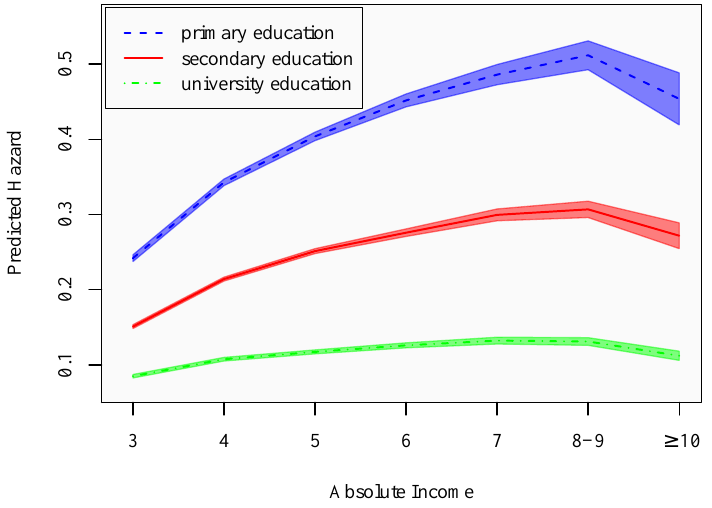
Figure 6. The effect of absolute income on the sickness absence